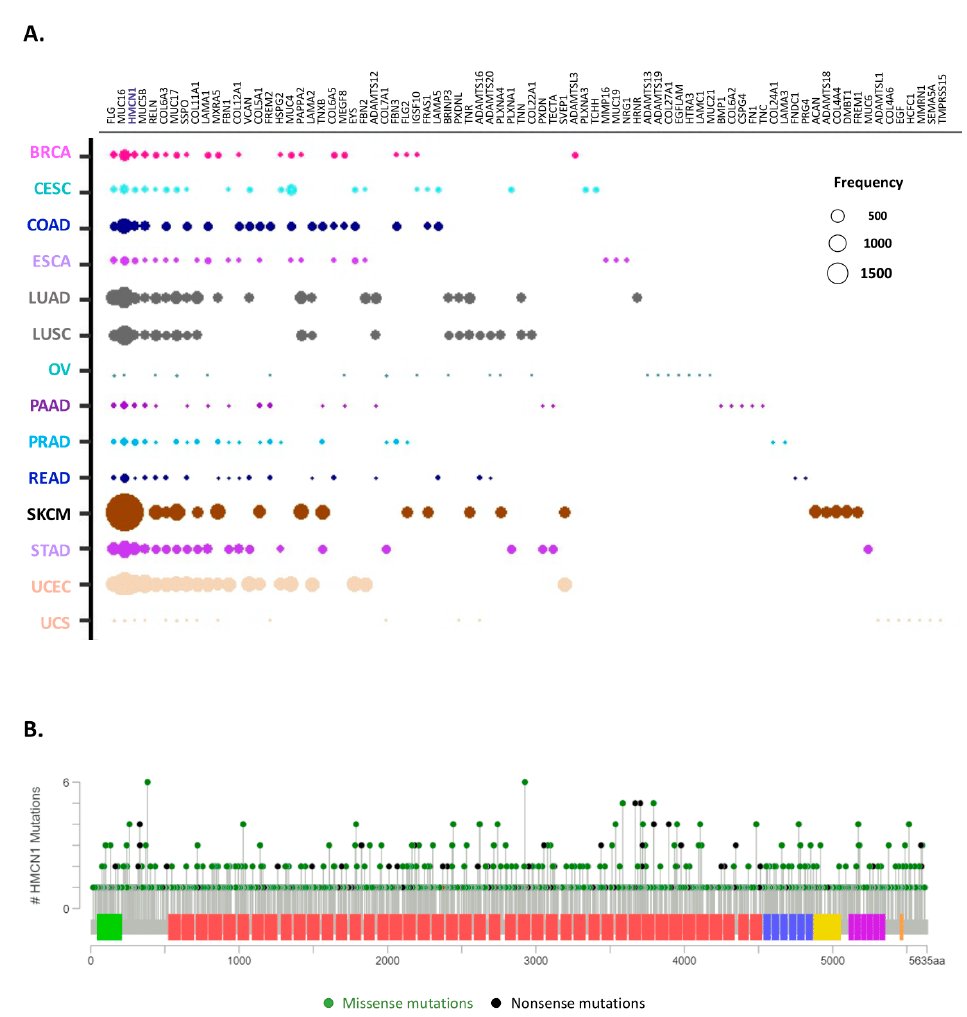
Figure 6. Top 10 most mutated matrisome genes. ( A ) Bubble plot represents the top 10 most frequently mutated genes in ECM proteins across all 14 cancer types analyzed. The diameter of the bubbles is proportional to the mutation frequency of each gene in each cancer type while the relative position along the x axis reflects the number of tumor types in which the gene is mutated (the leftmost genes being mutated in all tumor types analyzed). See also Table S4. ( B ) Lollipop charts show the mutational landscape for the most frequently mutated core matrisome gene, HMCN , encoding hemicentin. Missense mutations (green circles) and truncation mutations, including nonsense mutations, nonstop mutations, frameshift deletions, frameshift insertions or splice sites (black circles), are shown. Data and lollipop graphs were obtained from